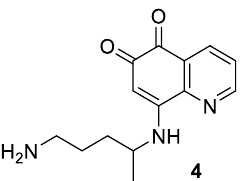
Figure 2. Key metabolite ( 4 ) of 8-aminoquinolines 2 and 3 .